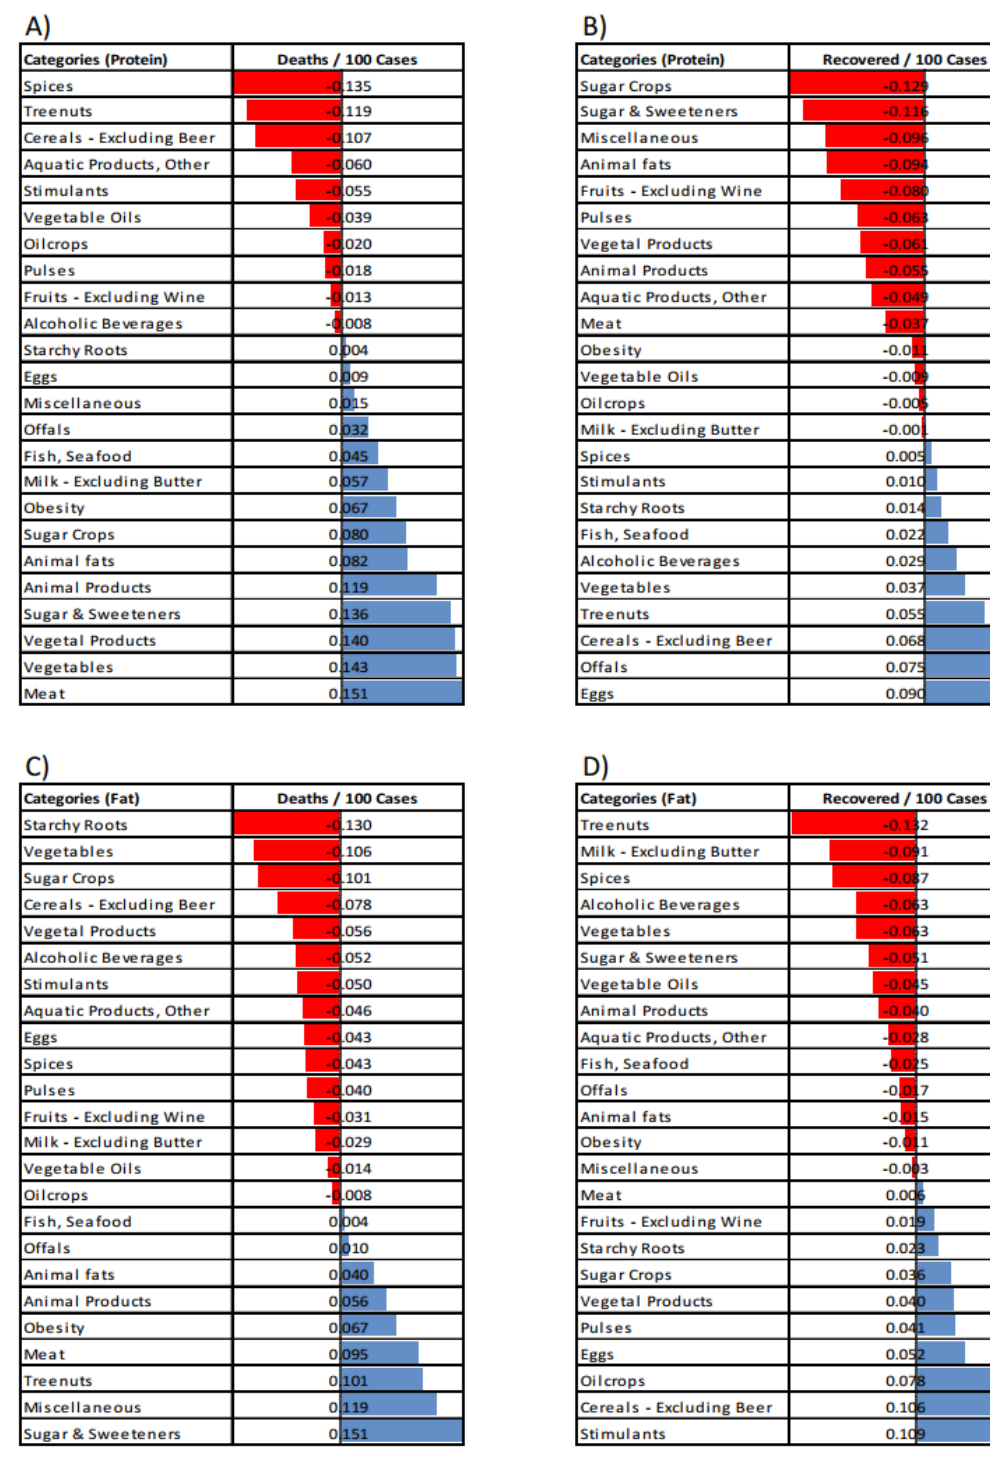
Figure 3. Bivariate Pearson correlation between nutrition categories (plus obesity) and the number of deaths (A and C) and the number of recoveries (B and D) in 100 cases of